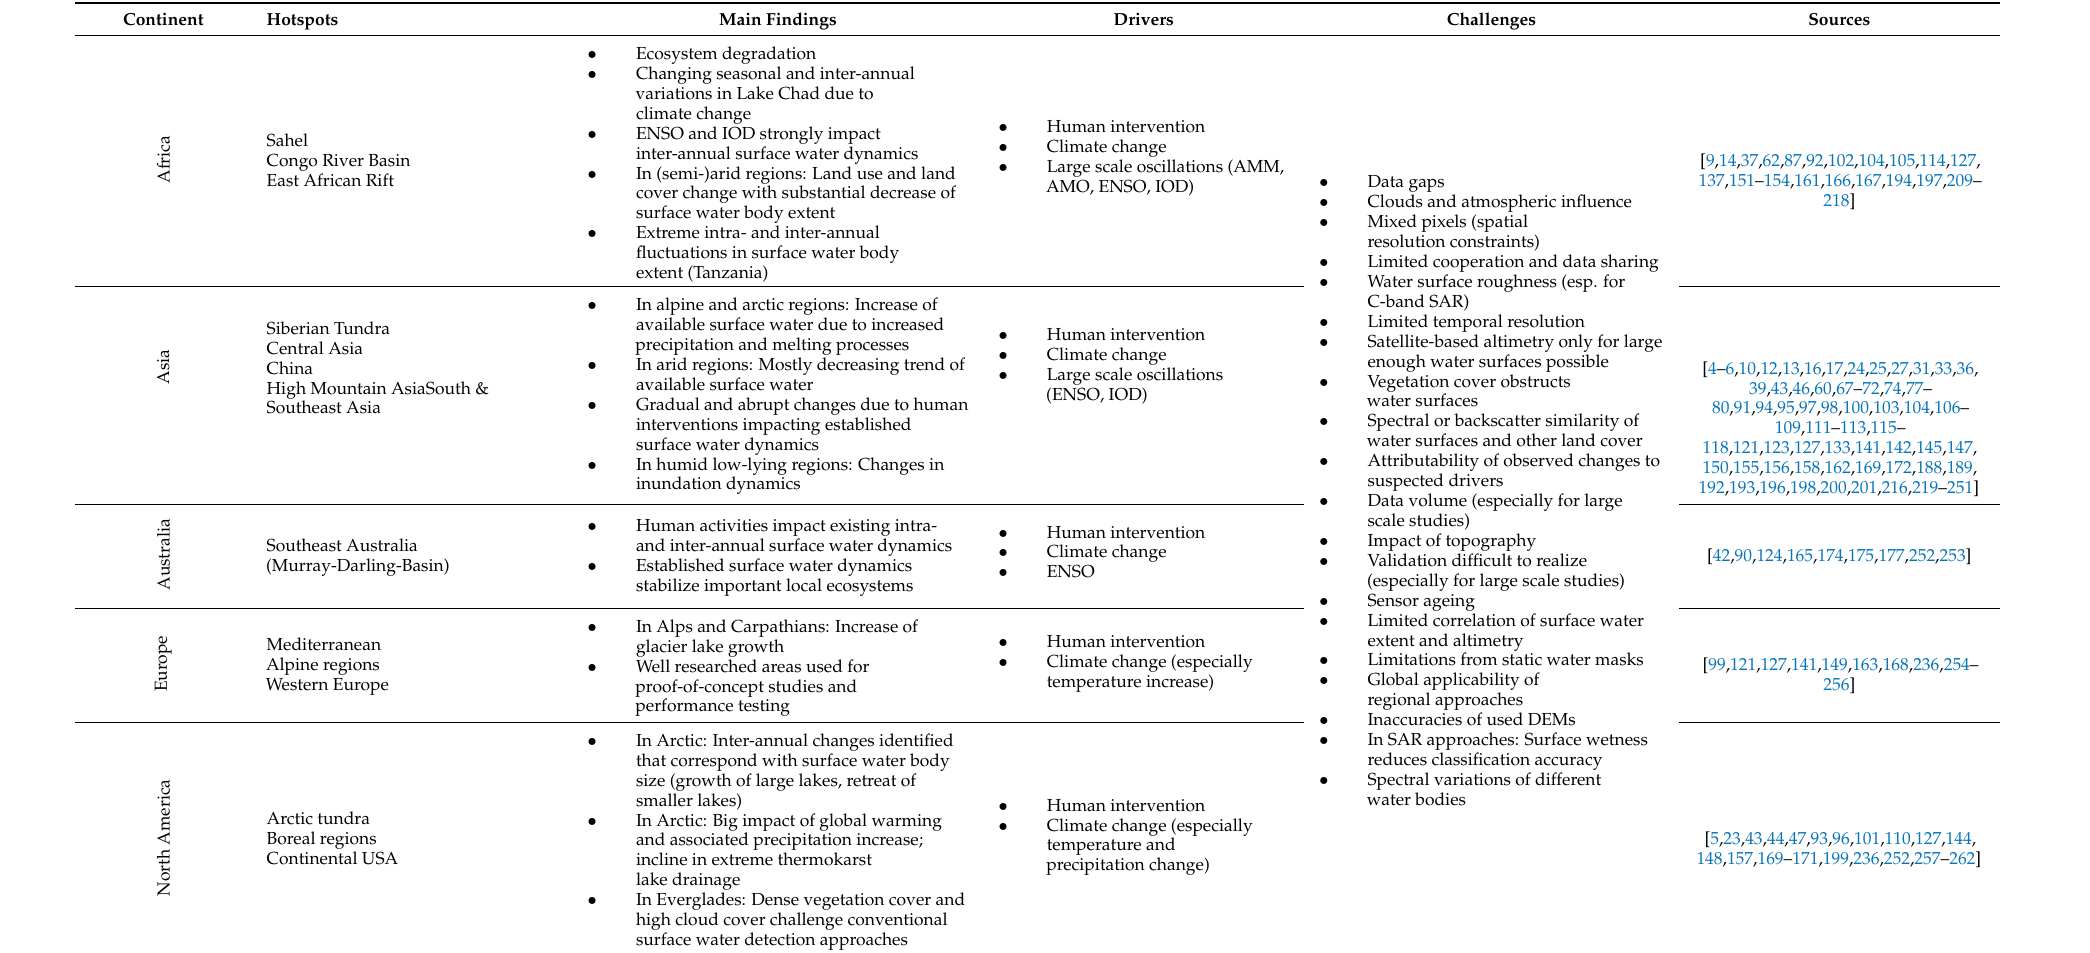
Table 2. Overview of researched areas, main findings, identified drivers, and